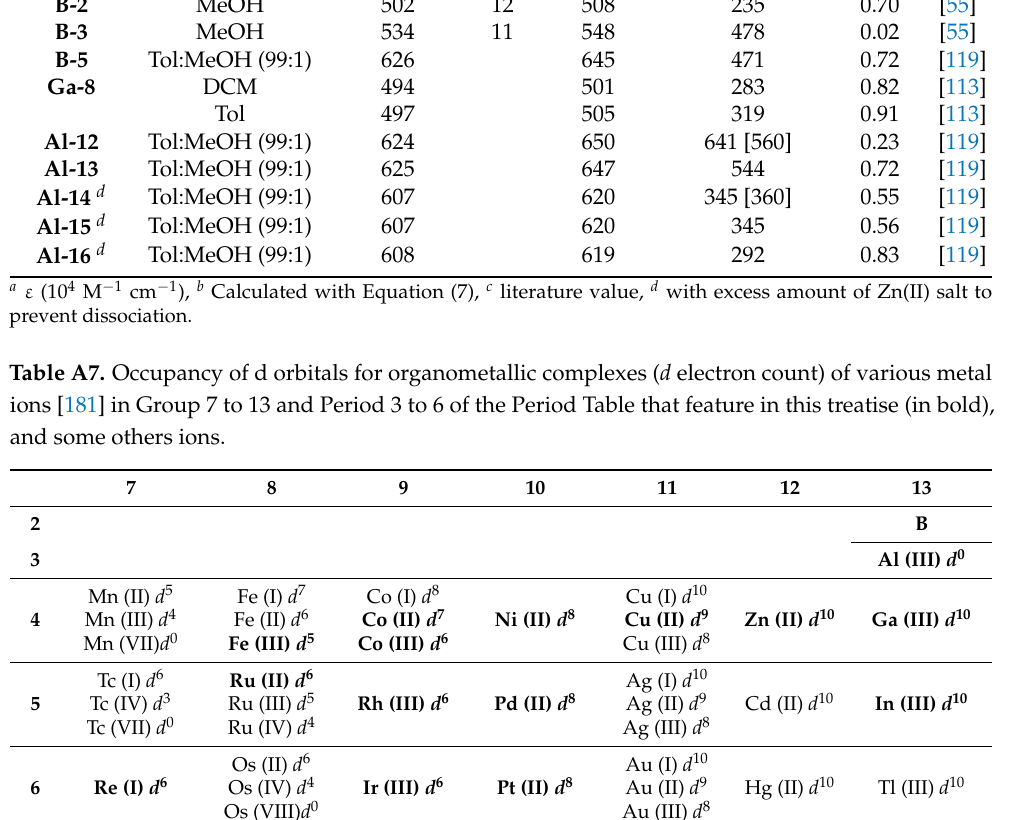
Table A6. Photophysical properties of p-block mono(dipyrrinato) (DIPY) complexes. DIPY